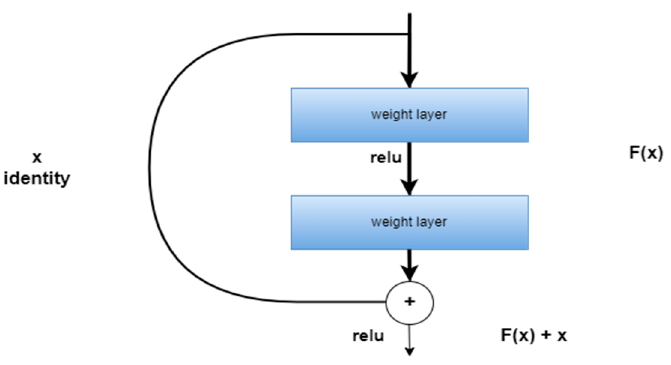
Figure 9. A visual example of residual block employed to develop the DSC-LSVM model. The function O ( x ) shows the real output value, and the residual layer learning is indicated by R ( x ) in the network input x.